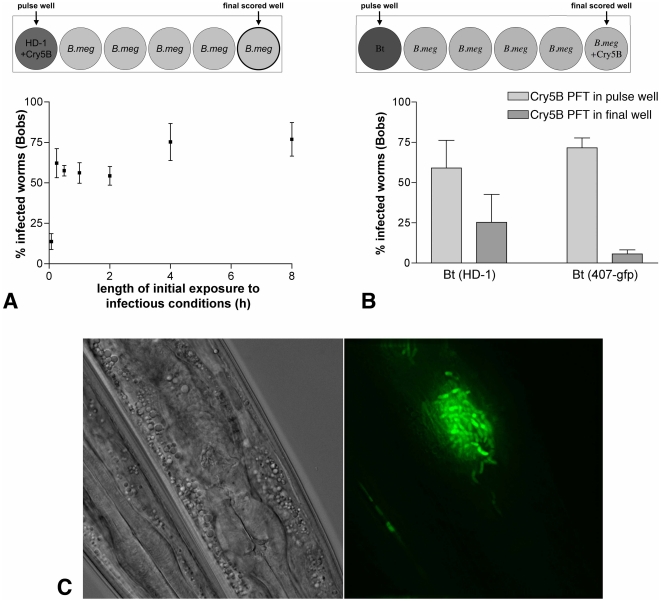
Temporal aspects of the infection process.(A) Infections are established upon a short exposure to pathogen. Upper: schematic of experiment. Worms are added to the well on the left containing B. thuringiensis and Cry5B. Following either 5 min, 15 min, 30 min, 1 h, 2 h, 4 h, or 8 h, the worms were then moved through a series of five wells lacking Cry5B protein and containing non-infectious B. megaterium instead of B. thuringiensis. Infection outcomes in the final well were scored 48 h later. Lower: results of the experiment depicted in upper schematic. Data shown represent a total of three independent experiments with ∼30 animals per time point per experiment. Error bars indicate SEM. Only the infection rate for a 5-minute pulse is significantly different from the other data points (ANOVA, p<0.05, Tukey's post test). (B) Cry5B acts early in the infection process as temporal addition of Cry5B protein after, and separate from, pathogen exposure results in a significant drop in infections. Upper: schematic of experiment in which worms are exposed to pathogen first and then to Cry5B. Lower: results in which two sets of experiments were set up simultaneously—a normal 15 minute pulse chase with both Cry5B PFP and pathogen added together (light gray bars; see (A) for set up) and pulse chase in which Cry5B was not added until the end (dark gray bars). Error bars represent SEM. ∼30 worms/condition/trial; 3–4 independent trials per condition. (C) The infection process appears to begin with colonization of the anterior intestine. The anterior intestine of a nematode 3 hr after exposure to B. thuringiensis (407-gfp) under pathogenic conditions. The left panel is a DIC image; the right panel deconvolved fluorescent (FITC) of the same animal. Images taken at 600×. Anterior is down.